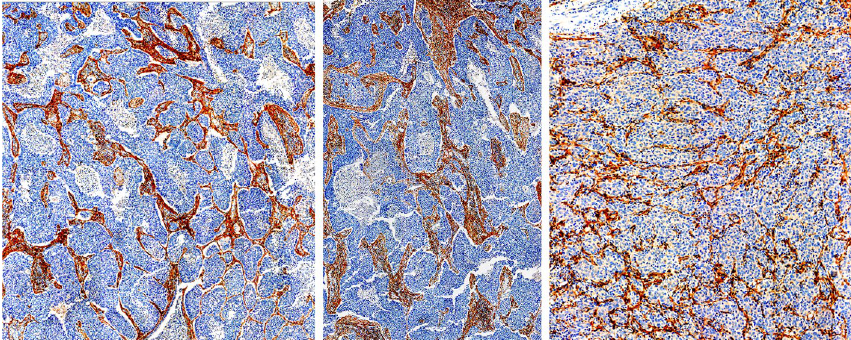
Fig. 1 CAFs immunochemistry images of NSCLC (left and middle) and gastric adenocarcinoma (right). Cell nuclei are visible in blue and FAP in red